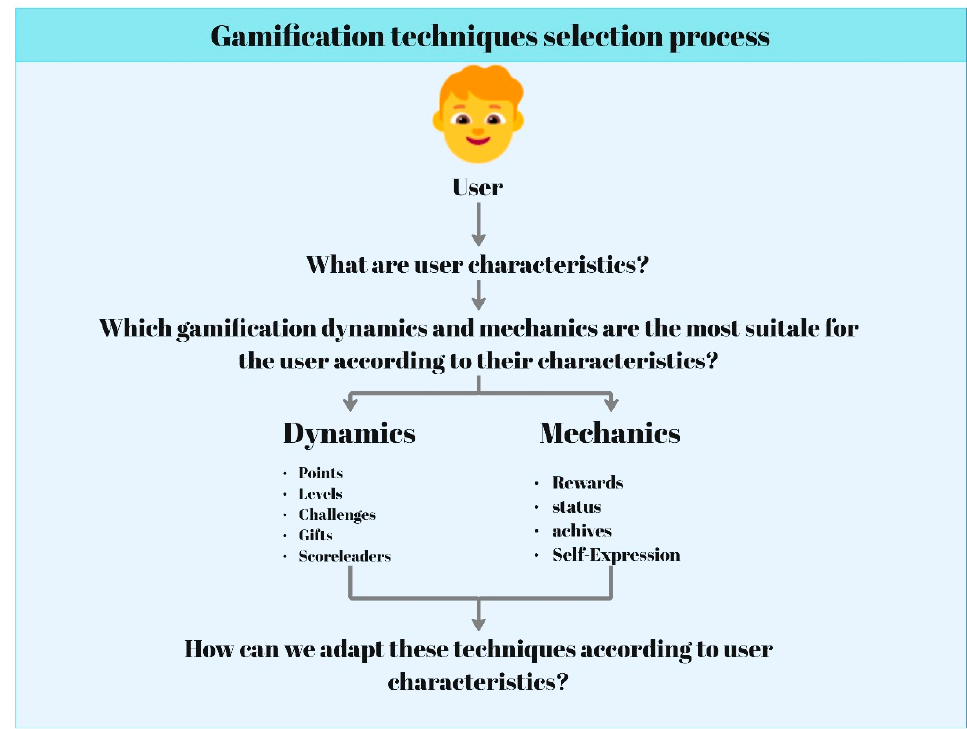
Figure 2. Gamification techniques selection process used in this investigation.